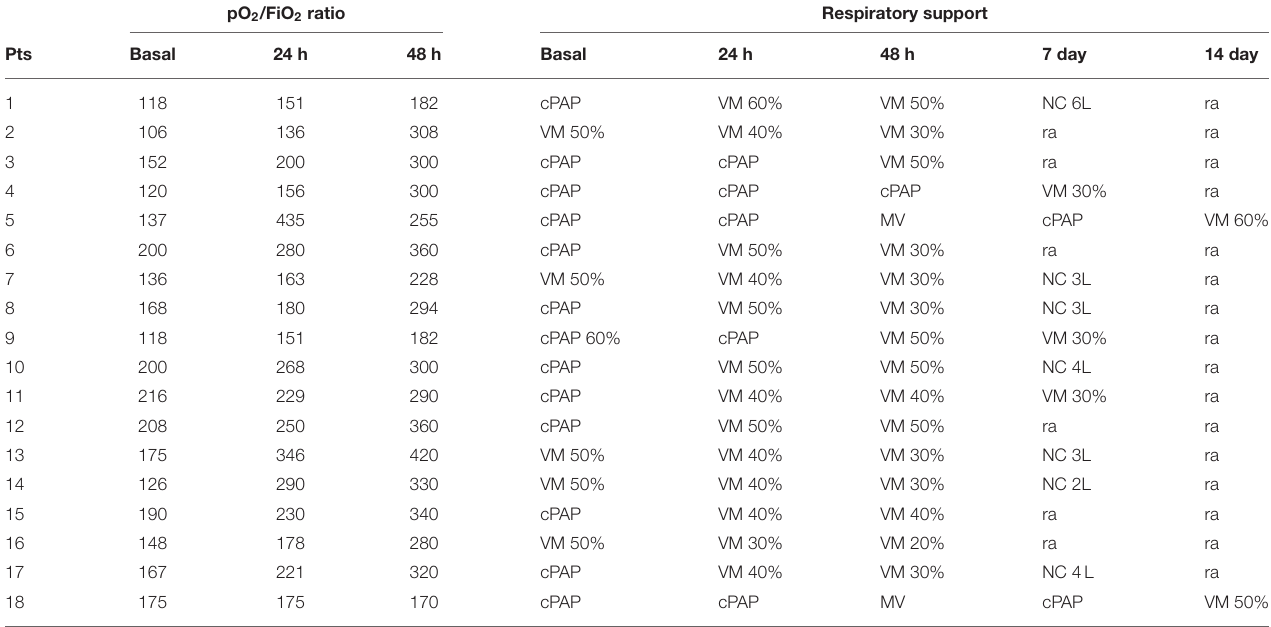
TABLE 3 | pO 2 /FiO 2 ratio and respiratory support type. pO 2 /FiO 2 ratio